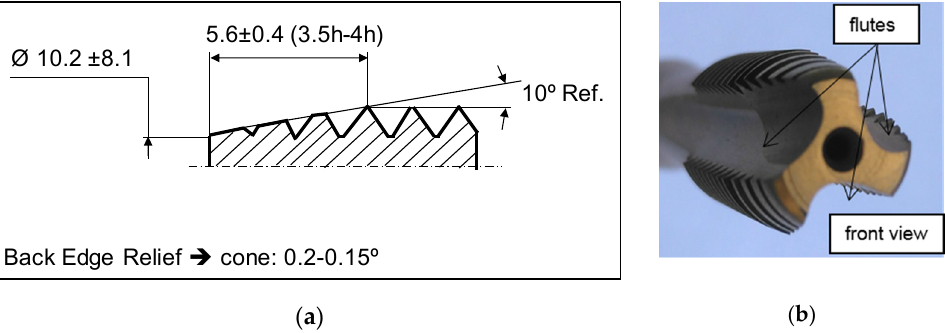
Figure 2. Tap geometry, profile of the tool tip ( a ) and front view of the tap tool with long three-flutes( b ).